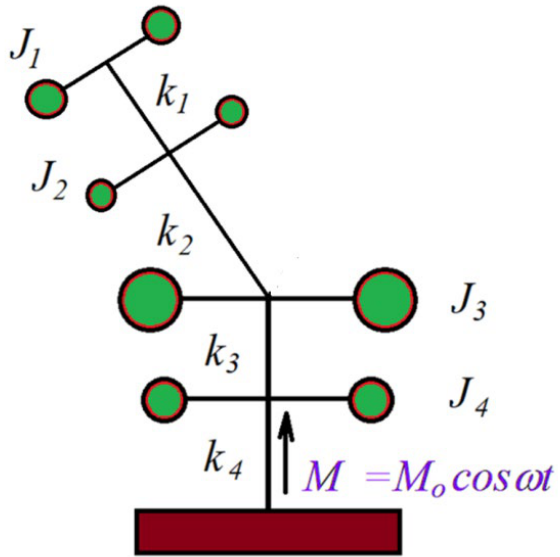
Figure 11. Elastic system with four wheels.